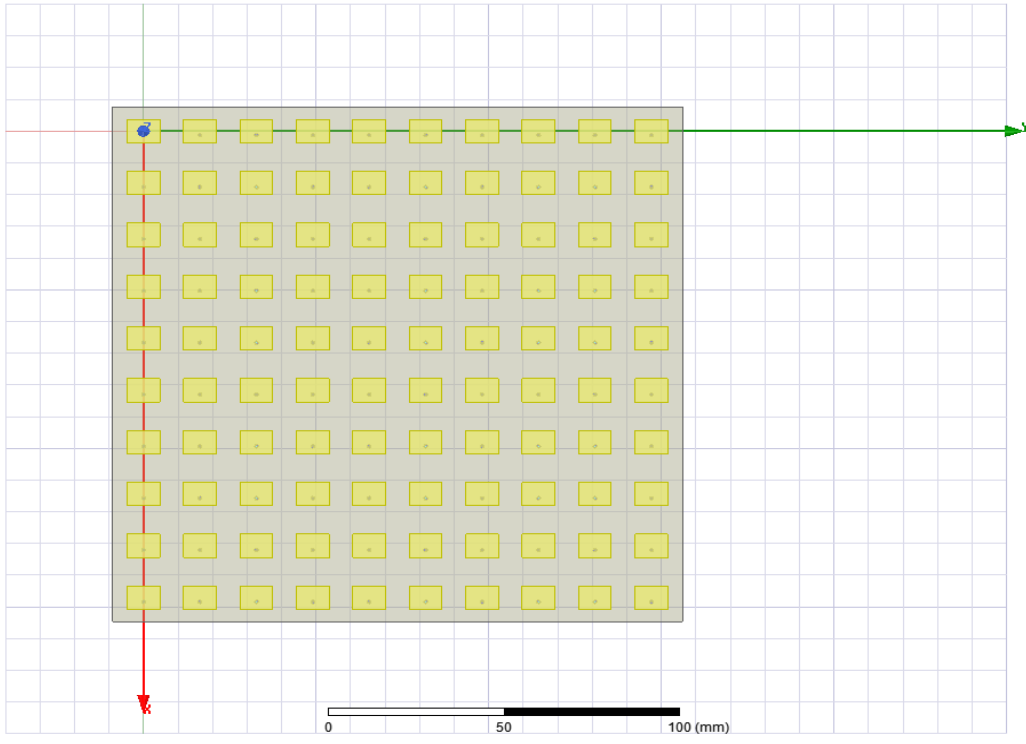
Figure 8. Designed microstrip patch antenna array in Ansys HFSS for diagnosis.